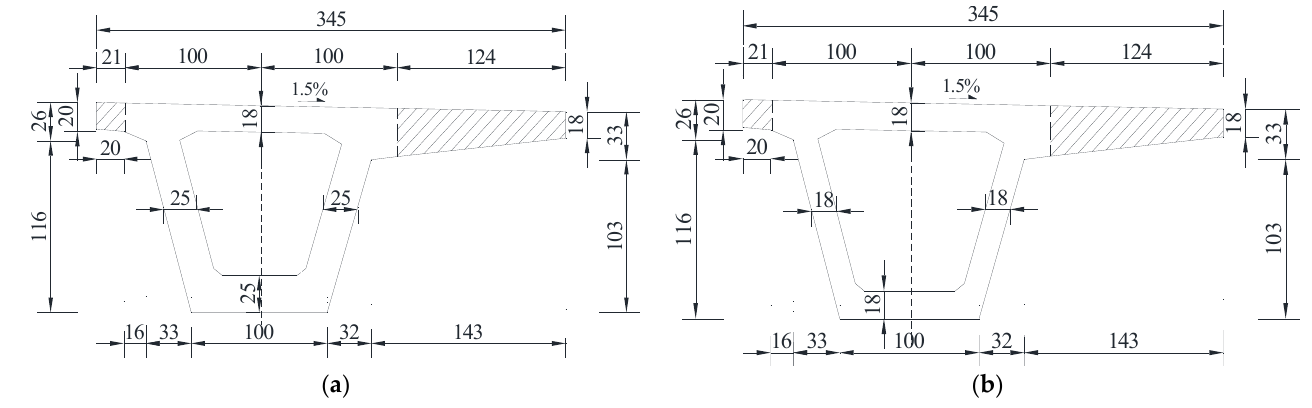
Figure 4. Cutting diagram of the box girder at the fourth span (Unit: cm). ( a ) A-A section; ( b ) B-B section. The arrangement of strands and steel bars in the box girder is shown in Figure 5, and the strength parameters of the concrete, strands and steel bars are shown in Table 1.